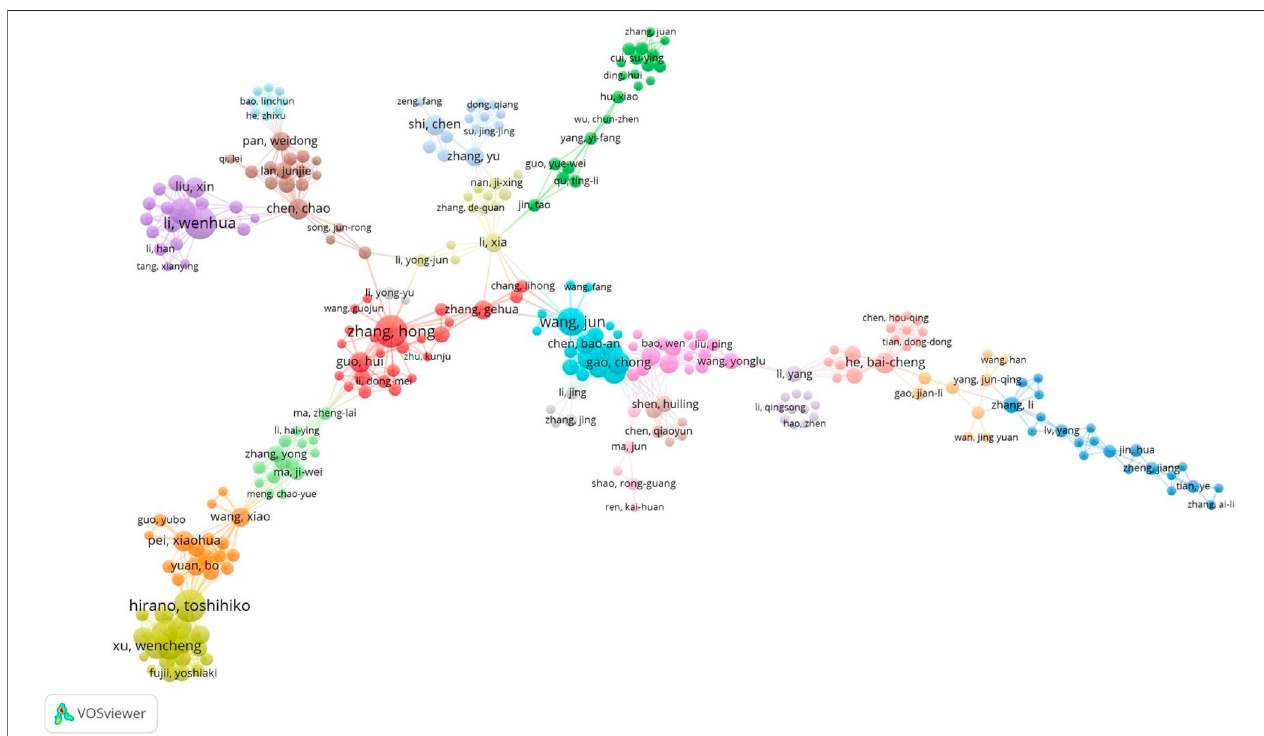
FIGURE 3 | Network visualization map of co-authorship in TET research.